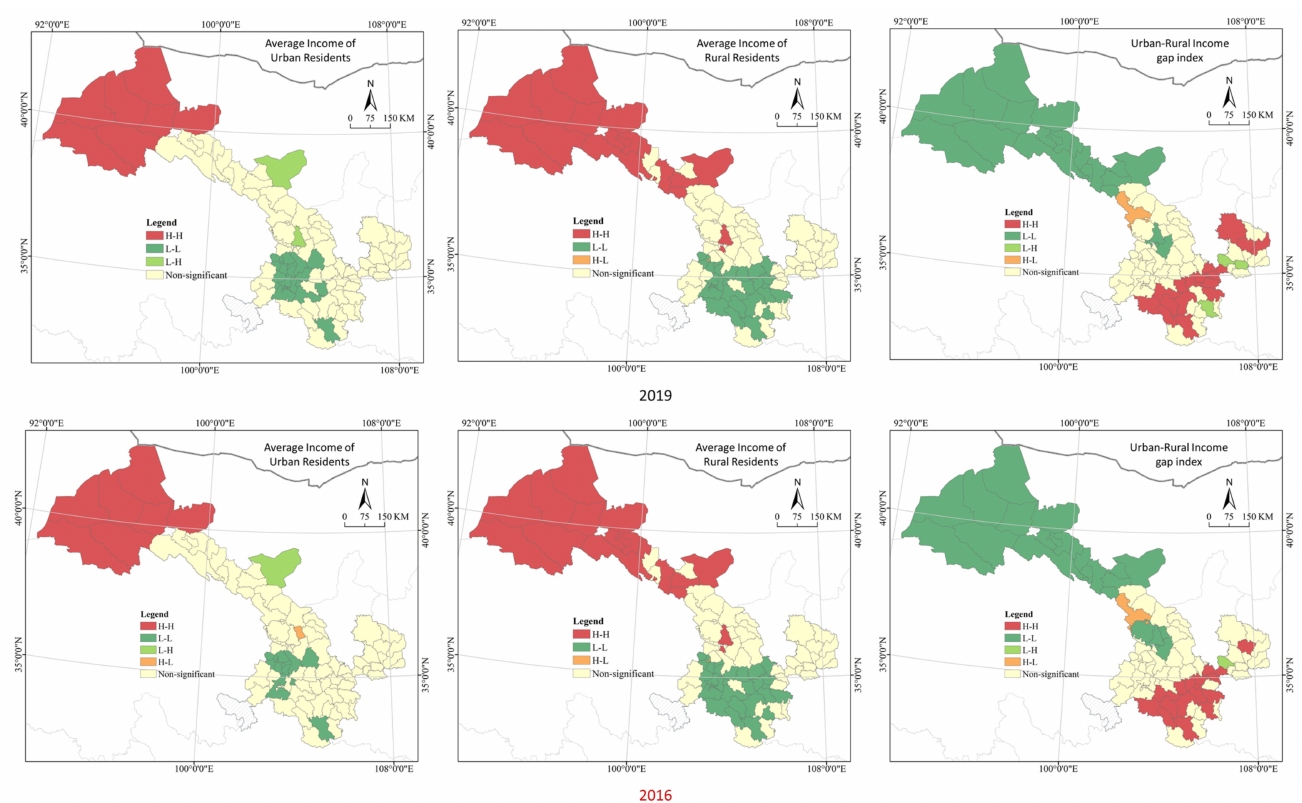
Figure 8. Analysis on Spatial